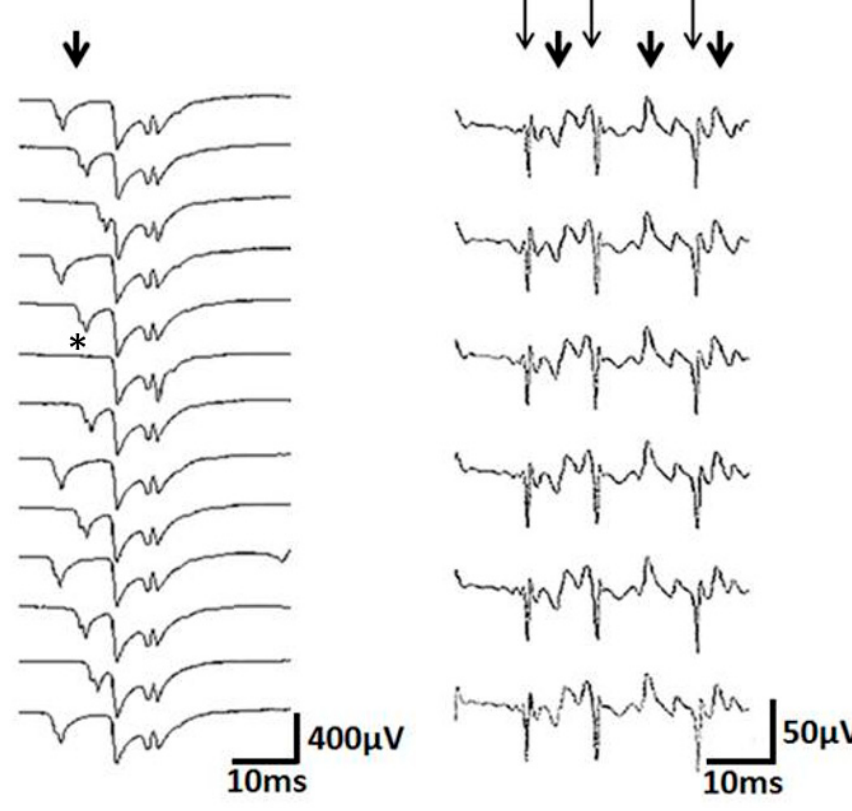
Figure 3. Left: note the blockade ( * ) and jitter (arrow) of the spike components. Note also that the jittering part is composed of at least 2 potentials that jitter together. This may be due to a nerve twig taking part in the jitter. Right: subsequent complex repetitive discharges (CRD), shown in a cascade manner. Note that the high frequency spike components (long thin arrows) alternate with the low frequency spike components (short thick arrows). This contiguity of needle-near and needle-far spikes can hardly be explained by ephaptic transmission from one muscle fiber to the next.